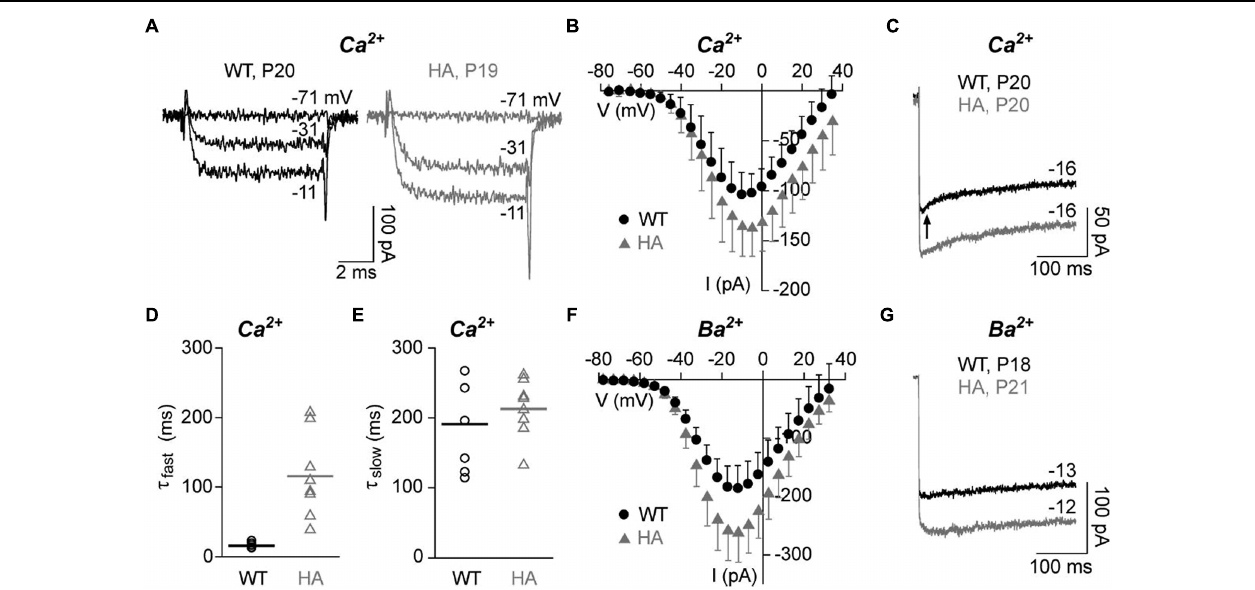
FIGURE 7 | Ca 2 + and Ba 2 + currents in adult IHCs (P18–21) of Cav1.3DCRD HA / HA and WT littermates. (A) Selected I Ca traces (10 mM Ca 2 + ) of a WT (black) and a Cav1.3DCRD HA / HA (HA, gray) mouse IHC after depolarization from a holding potential of − 86 mV for 8 ms to the indicated voltages. (B) Corresponding averaged I–V curves from 10 WT (black, mean + SD) and 12 Cav1.3DCRD HA / HA IHCs (gray, mean – SD) taken between 7 and 8 ms after start of the depolarizing pulse. (C) Representative traces of I Ca inactivation of WT (black) and a Cav1.3DCRD HA / HA (gray) IHC during a 300-ms depolarizing step to V max . The arrow indicates the early phase with faster inactivation absent in Cav1.3DCRD HA / HA and in Ba 2 + recordings. (D) Parameters of I Ca inactivation of 8 WT and 8